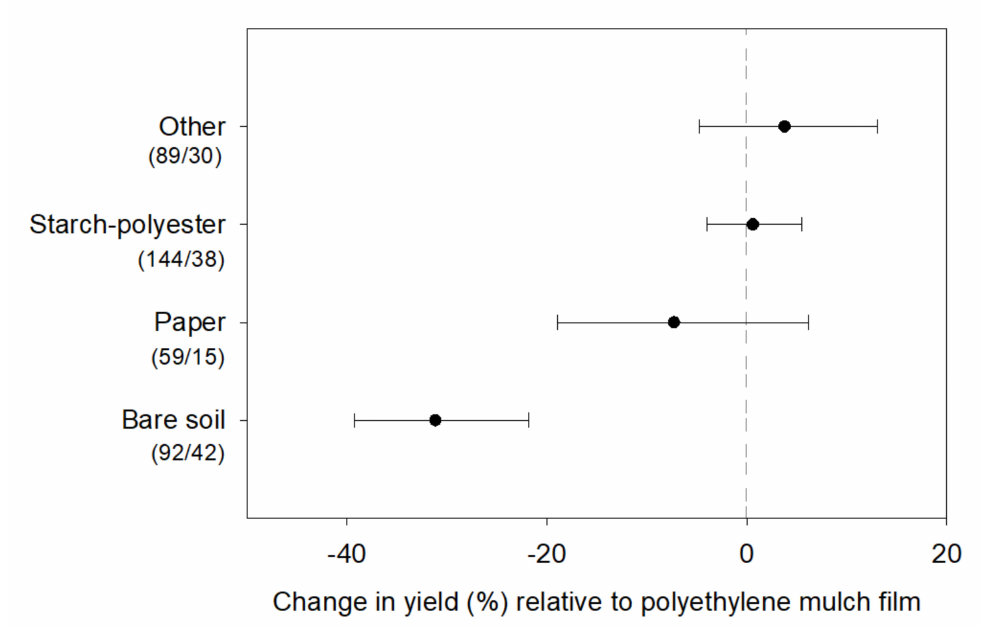
Figure 5. Mean change in crop yield as influenced by bare soil and biodegradable mulch type (relative to polyethylene mulch film). Numbers below y-axis labels indicate the number of observations and studies (left / right, respectively) contributing to each mean. Error bars represent 95% confidence intervals determined via